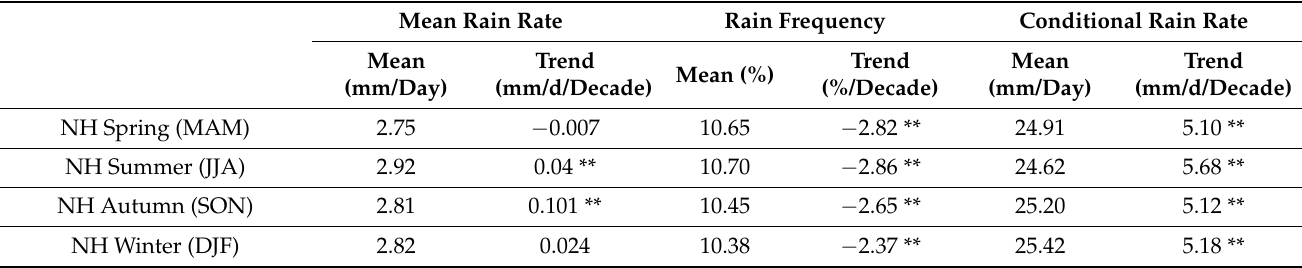
Table 2. Seasonal averages and trends of precipitation parameters. Trends without any asterisk have not passed the 0.1 significance level. MAM is short for March, April, and May; JJA is short for June, July, and August; SON is short